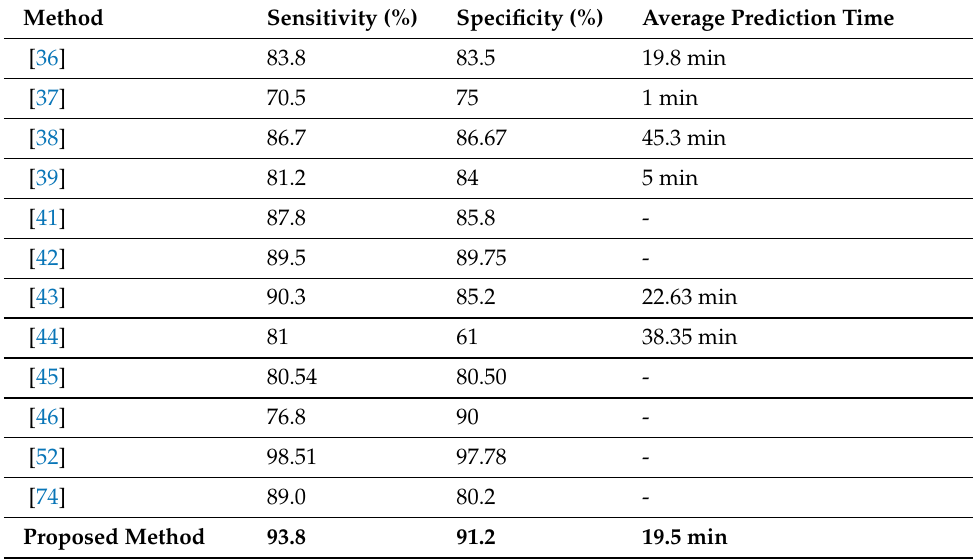
Table 8. Comparison of Sensitivity, Specificity and Average Anticipation time with recent techniques proposed by